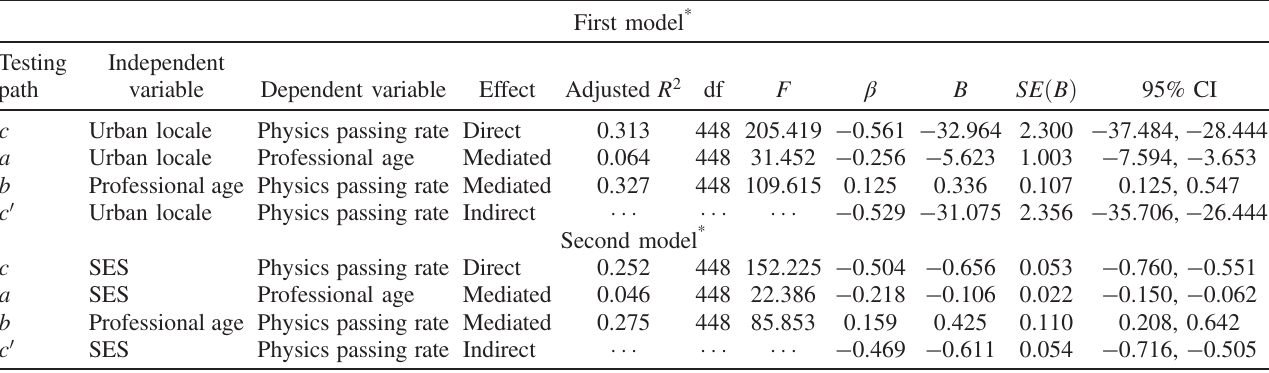
TABLE X. Professional age as a mediator of physics